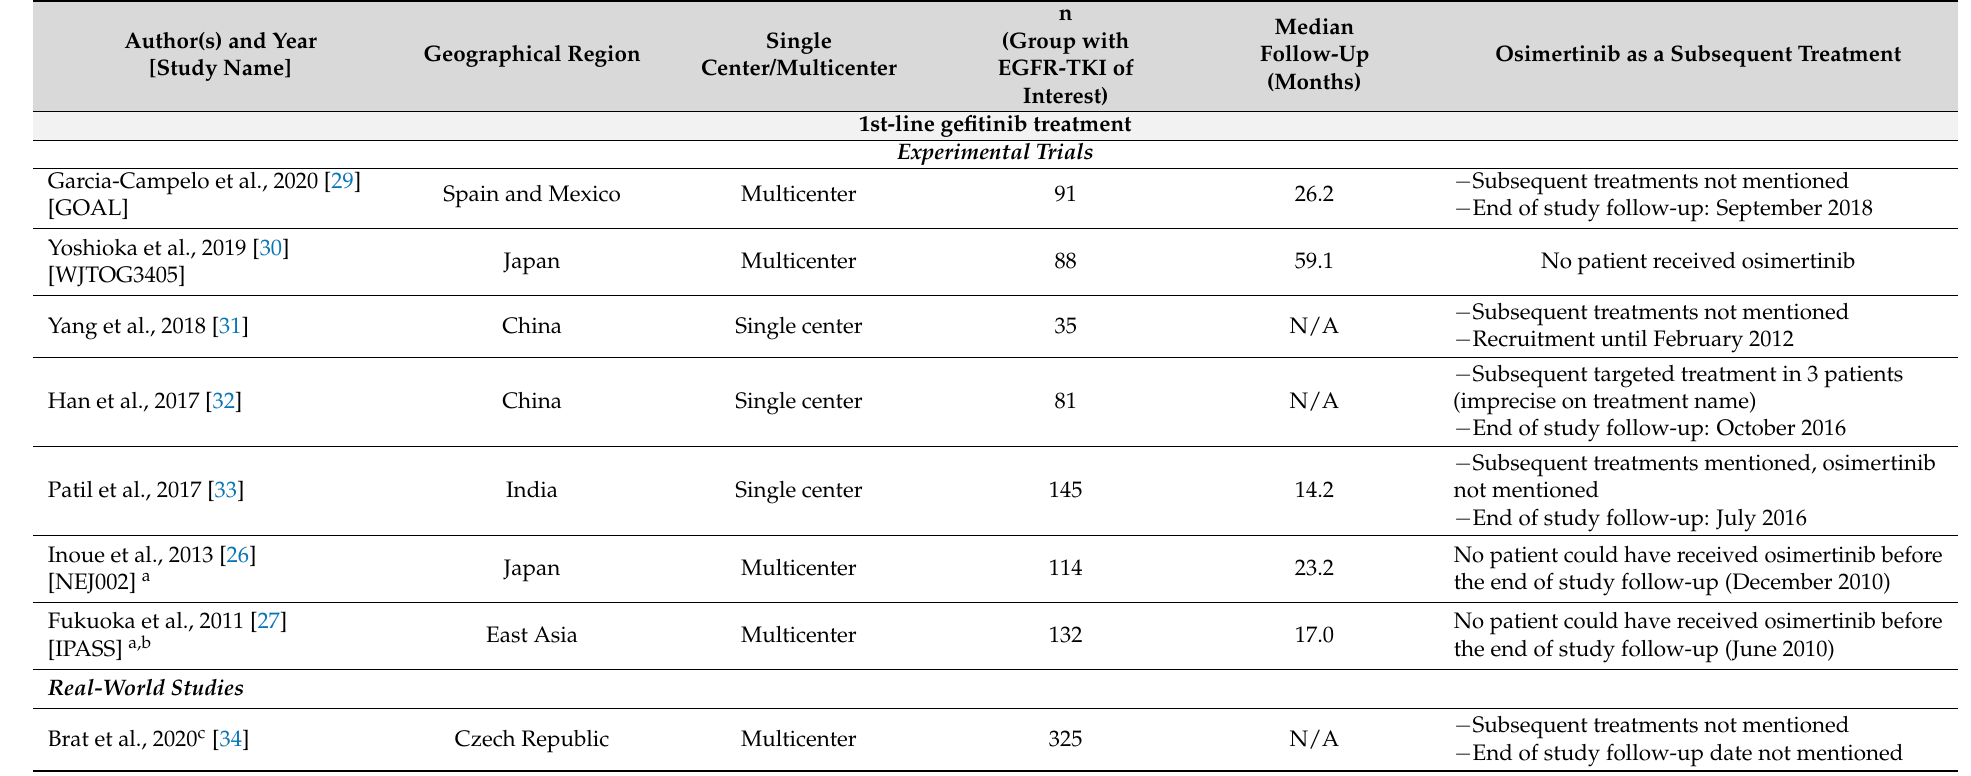
Table A7. Articles Included for Indirect Comparison of Median Overall Survival